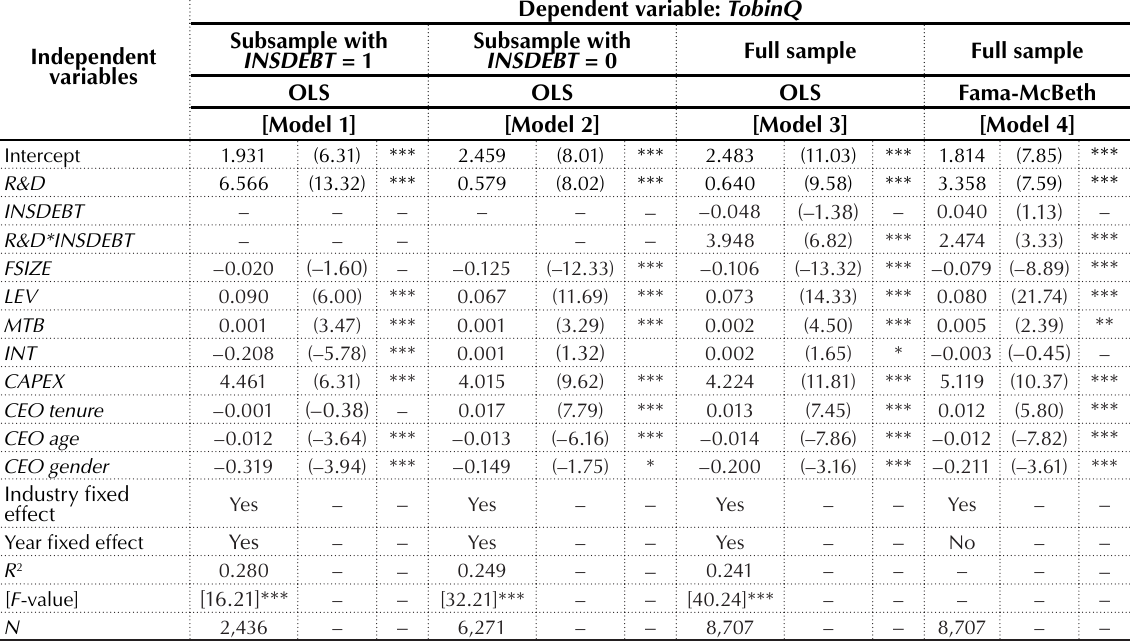
Table 3. Regression of Tobin’s (1969) Q ratio on R&D expenditures and CEO pensions Independent